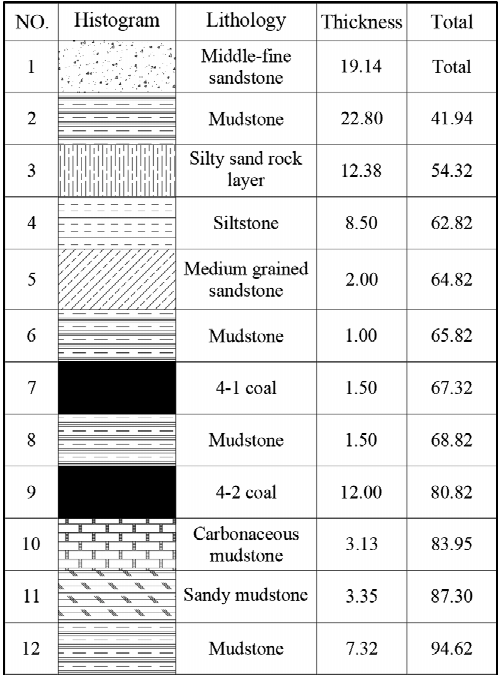
Figure 3. Rock layer column diagram.